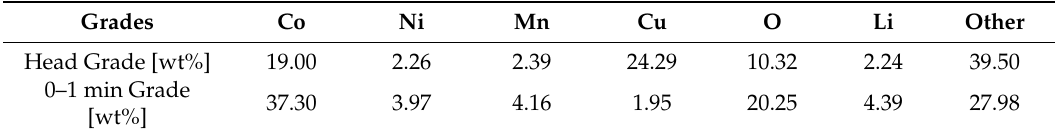
Table 2. The composition of the combined 0–1 min froth fractions (obtained from two experiments with 20 min milling time), and the average head grade of the